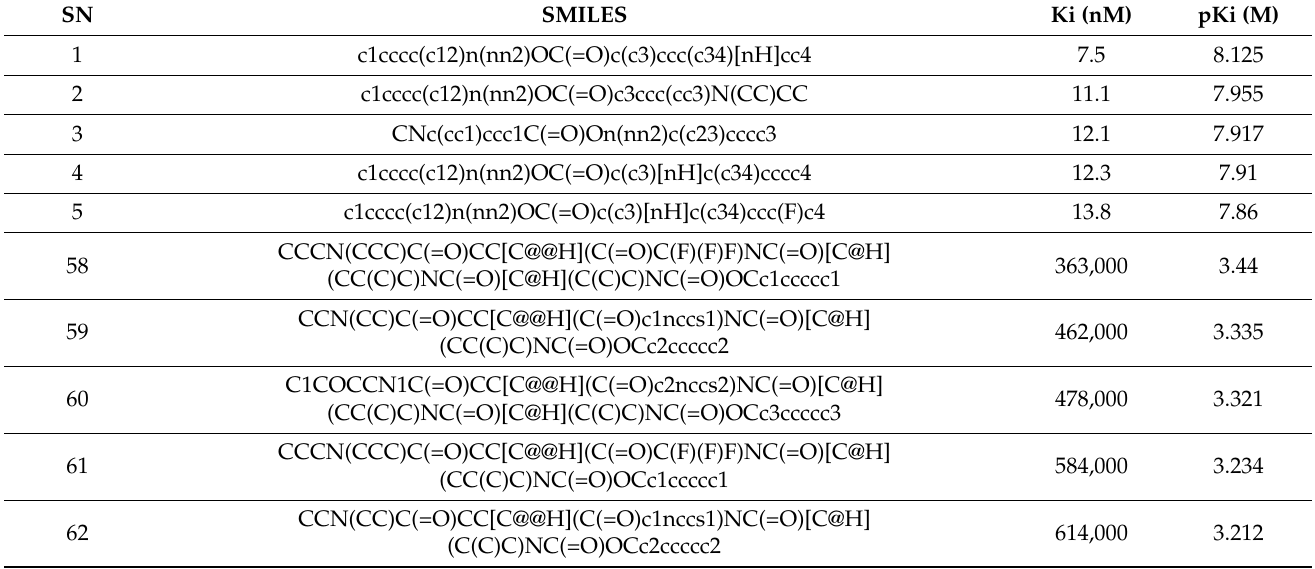
Figure 6. Representative examples of different classes of molecules used in the present work. (Bold numbers indicate serial number of molecules in the data set). Table 5. Simplified Molecular − Input Line − Entry System (SMILES) notations, Ki(nM), and pKi(M) for top five most active and least active